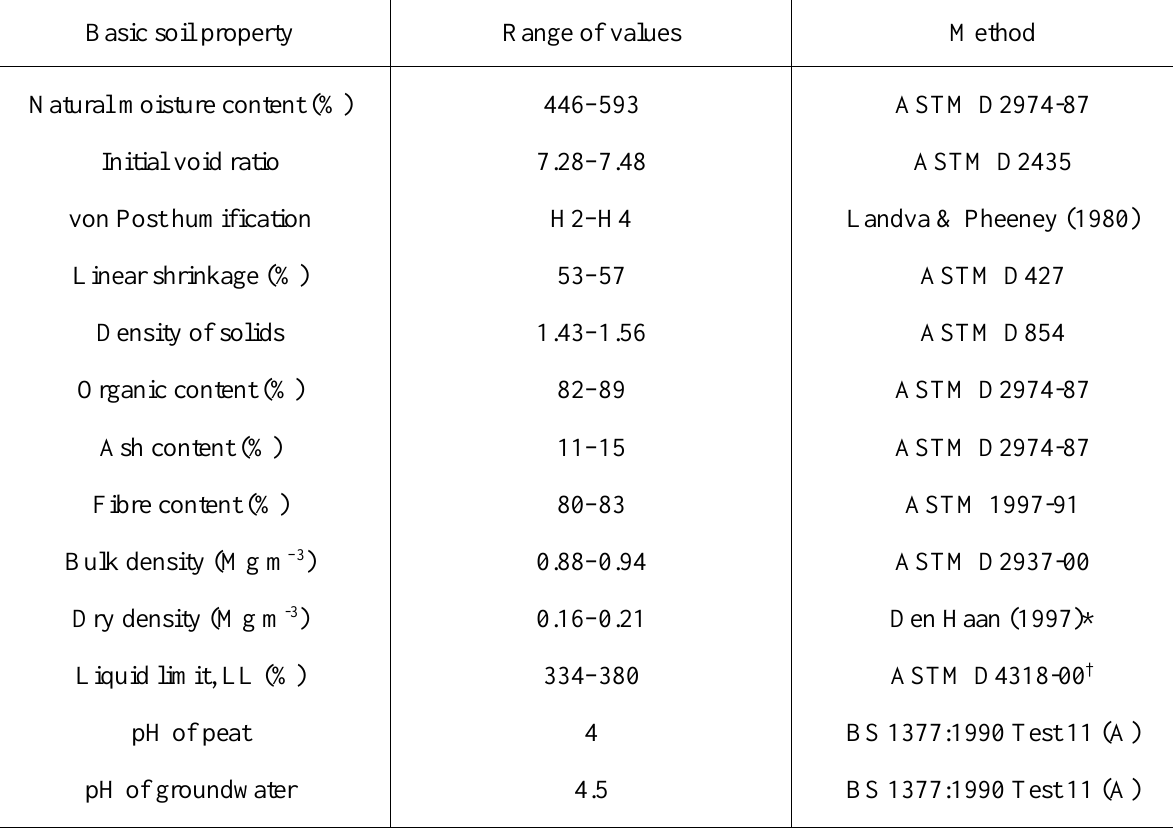
Table 2. Basic properties of Chaghakhor peat (adapted from Rahgozar & Saberian 2015). Basic soil